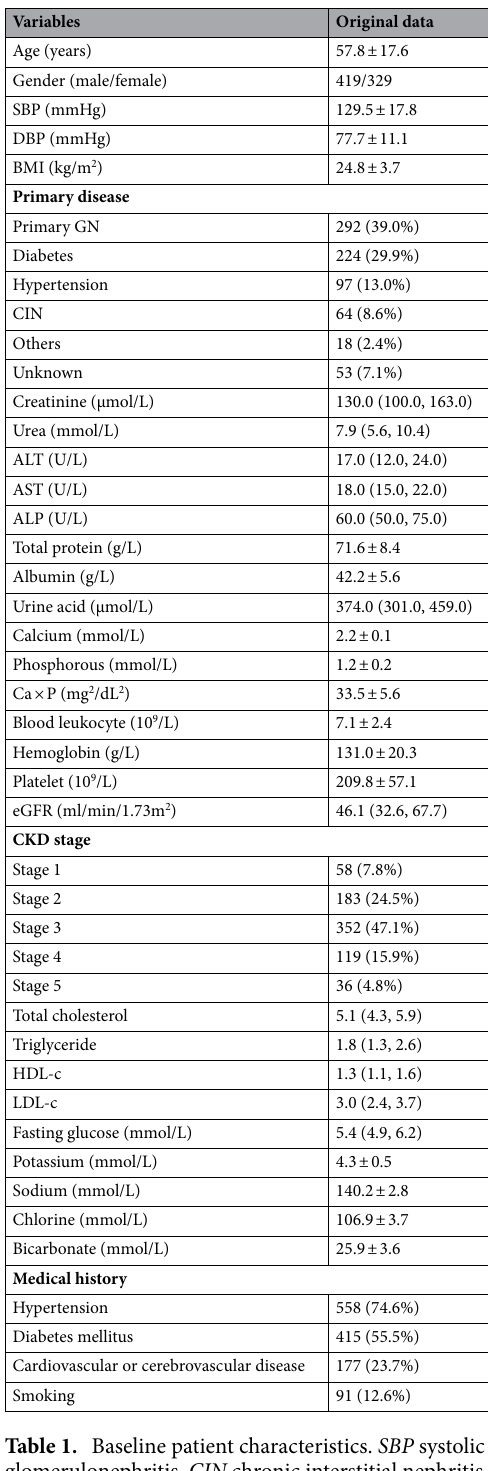
Table 1. Baseline patient characteristics. SBP systolic blood pressure, DBP diastolic blood pressure, GN glomerulonephritis, CIN chronic interstitial nephritis, BMI body mass index, eGFR estimated glomerular filtration rate, ALT alanine aminotransferase, AST aspartate transaminase, ALP alkaline phosphatase, CKD chronic kidney disease, HDL-c high density lipoprotein cholesterol, LDL-c low density lipoprotein cholesterol, Ca × P calcium-phosphorus